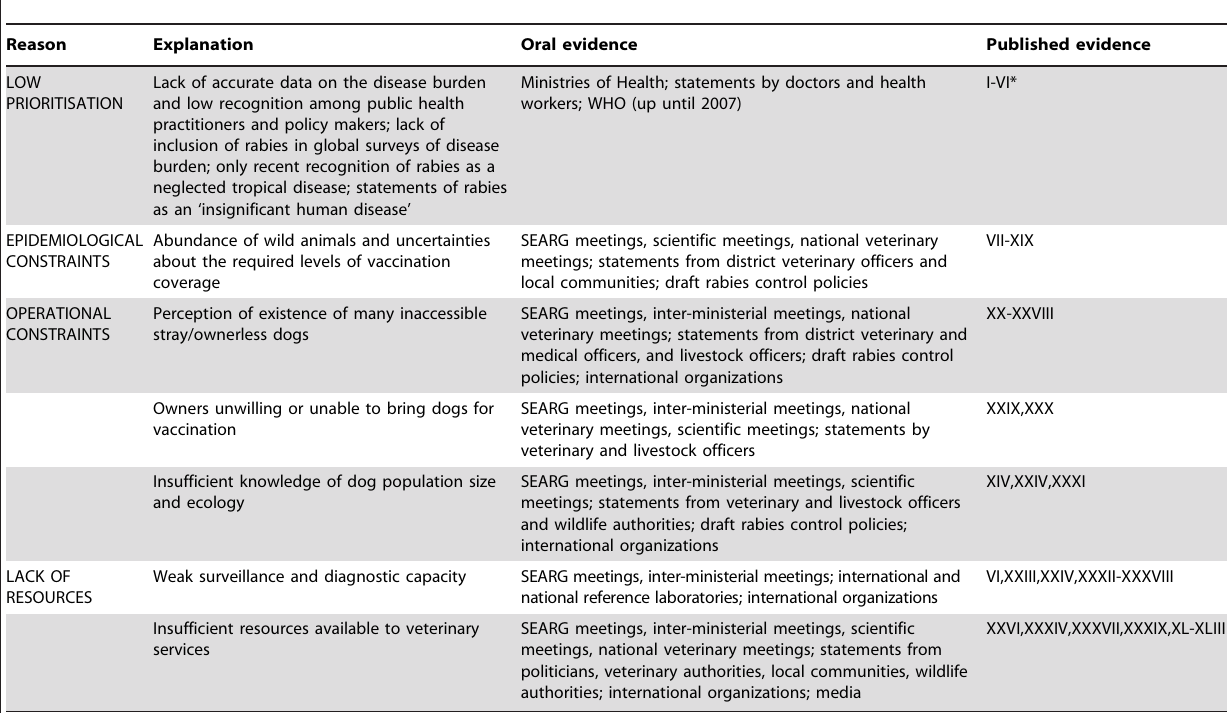
Table 1. Reasons commonly given for the lack of effective dog rabies